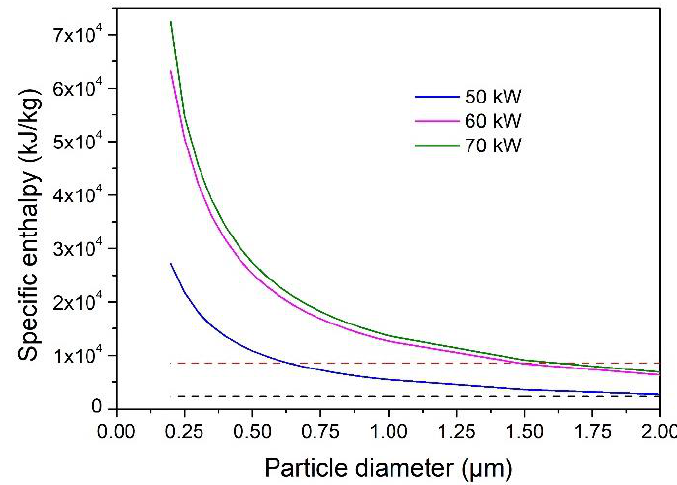
Figure 12. Effect of the torch net power on the specific enthalpy of particles stored over their travel inside the plasma torch (from injection point to nozzle exit); the horizontal red dotted line corresponds to the YSZ evaporation enthalpy (8561 kJ/kg) and black dotted lines to the YSZ melting enthalpy (2386 kJ/kg). 60 SLPM of argon, 30 SLPM of hydrogen, chamber pressure: 100 Pa.